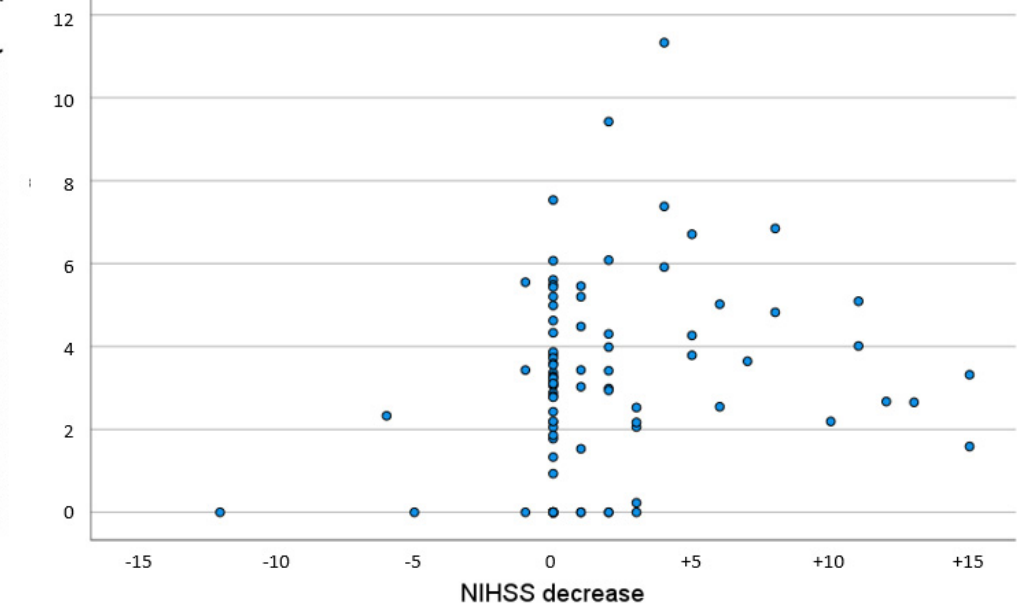
Figure 5. Correlation plot between the variation of NIHSS score in treated patients after 24 h of rt- PA administration and the amount of new compounds detected at time 1 (2 h after rt-PA) (r = 0.216, p = 0.041).